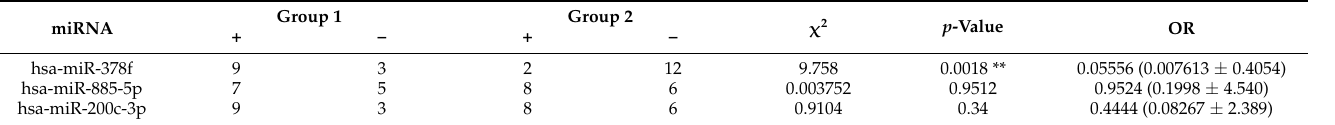
Table 3. Differential expression of three miRNAs in GC patients in groups 1 and